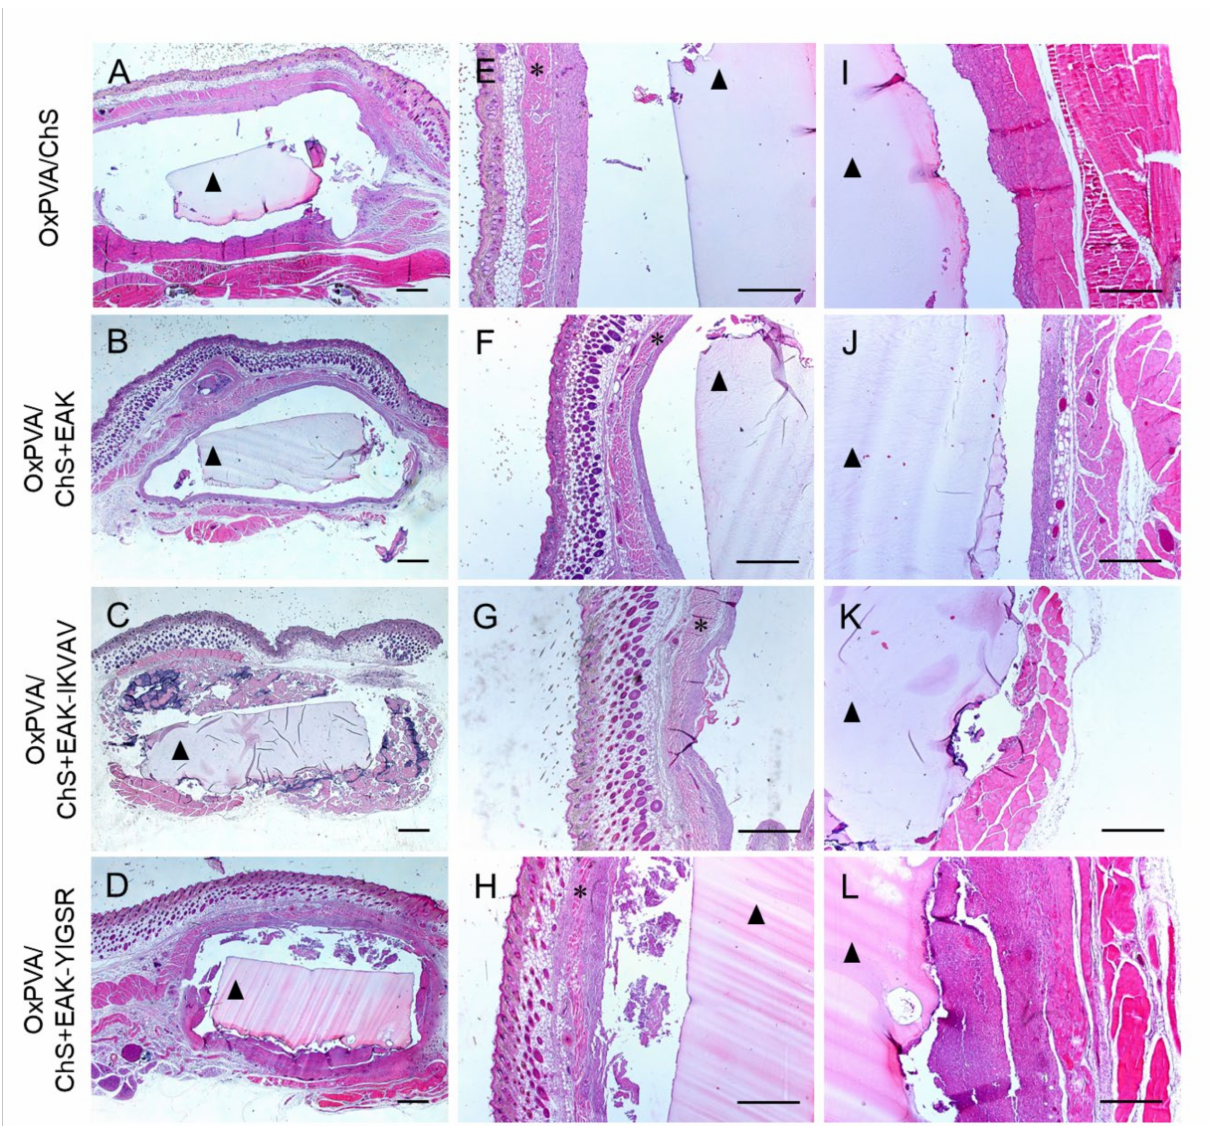
Figure 5. Hematoxylin and Eosin staining of OxPVA/ChS-based scaffolds integrated with surround- ing host tissues at the site of implant ( A – D ) and preliminary evaluation of the tissues at the superficial ( E – H ) and deep ( I – L ) aspects of the grafts. Scale bar: 800 µ m ( A – H ); 400 µ m ( I – L ). (*: the panniculus carnosus within the host subcutaneous tissue; (cid:78) : the OxPVA-based